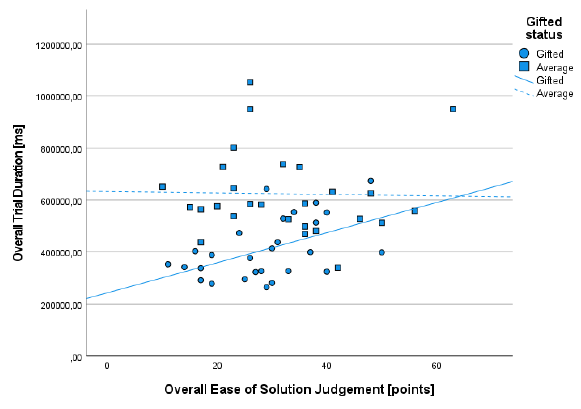
Figure 6. The scatterplot depicting relation between overall EoSJ and overall trial duration, with inserted lines showing linear trend, separately for gifted and average